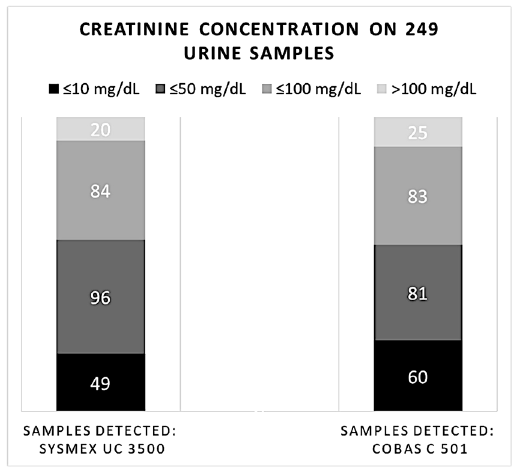
Figure 5. Comparison of 249 samples of creatinuria measured using the semi-quantitative and the quantitative methods categorized on MEDITAPE UC-11A ranges (mg/dL).